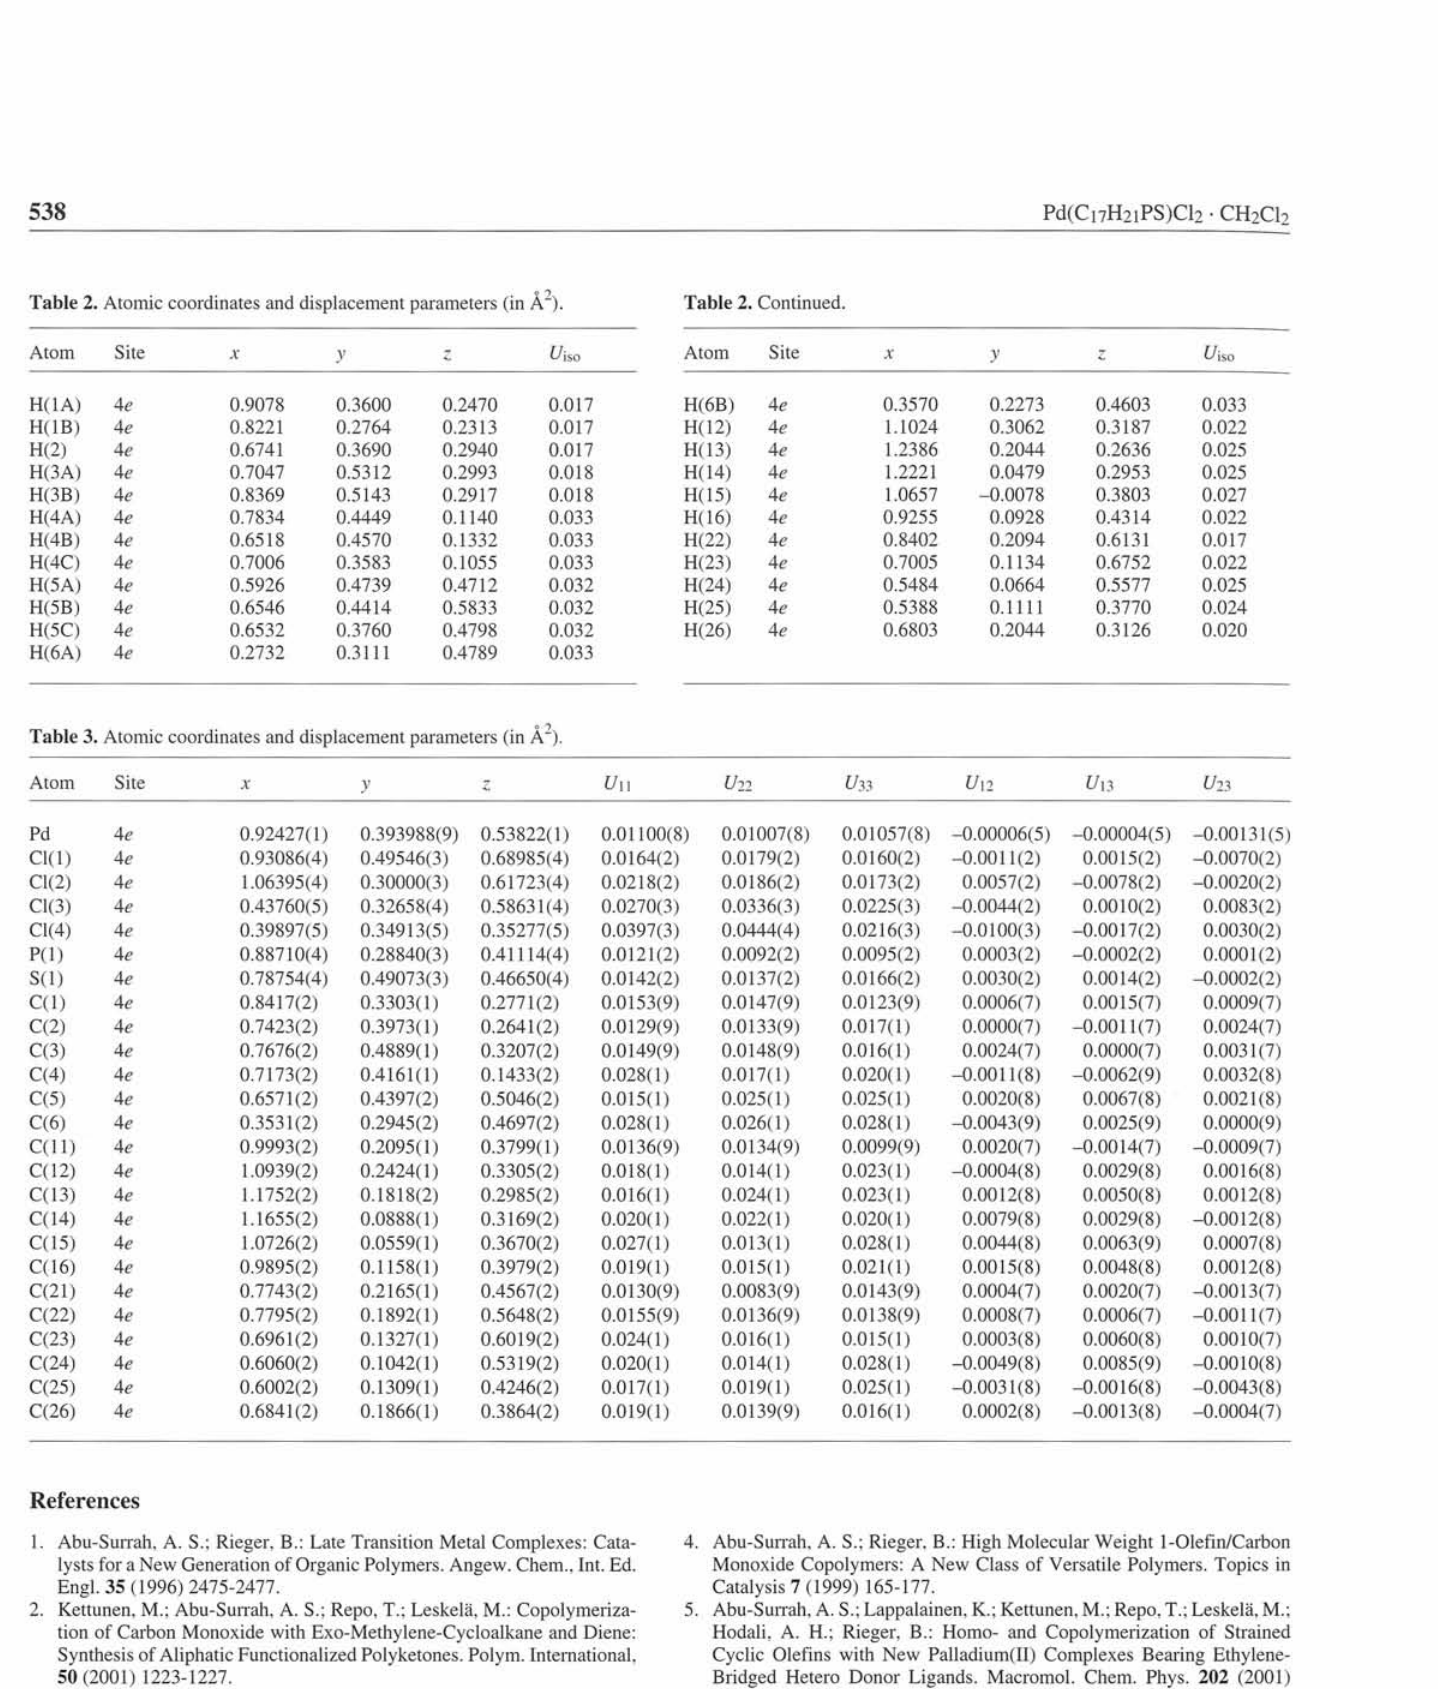
Table 2. Atomic coordinates and displacement parameters (in Á 2 ). Table 2. Continued.